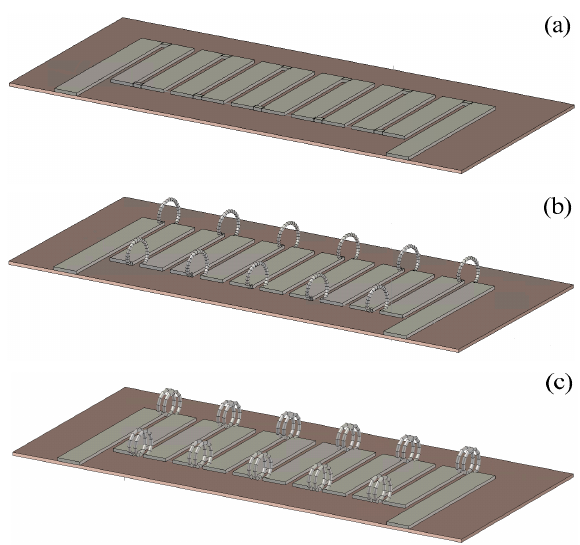
Figure 1. ( a ) Meander system; ( b ) Hybrid meander system with one turn in the peripherals; ( c ) Hybrid meander system with two turns in the peripherals visualized in the CST Microwave Studio ® environment.